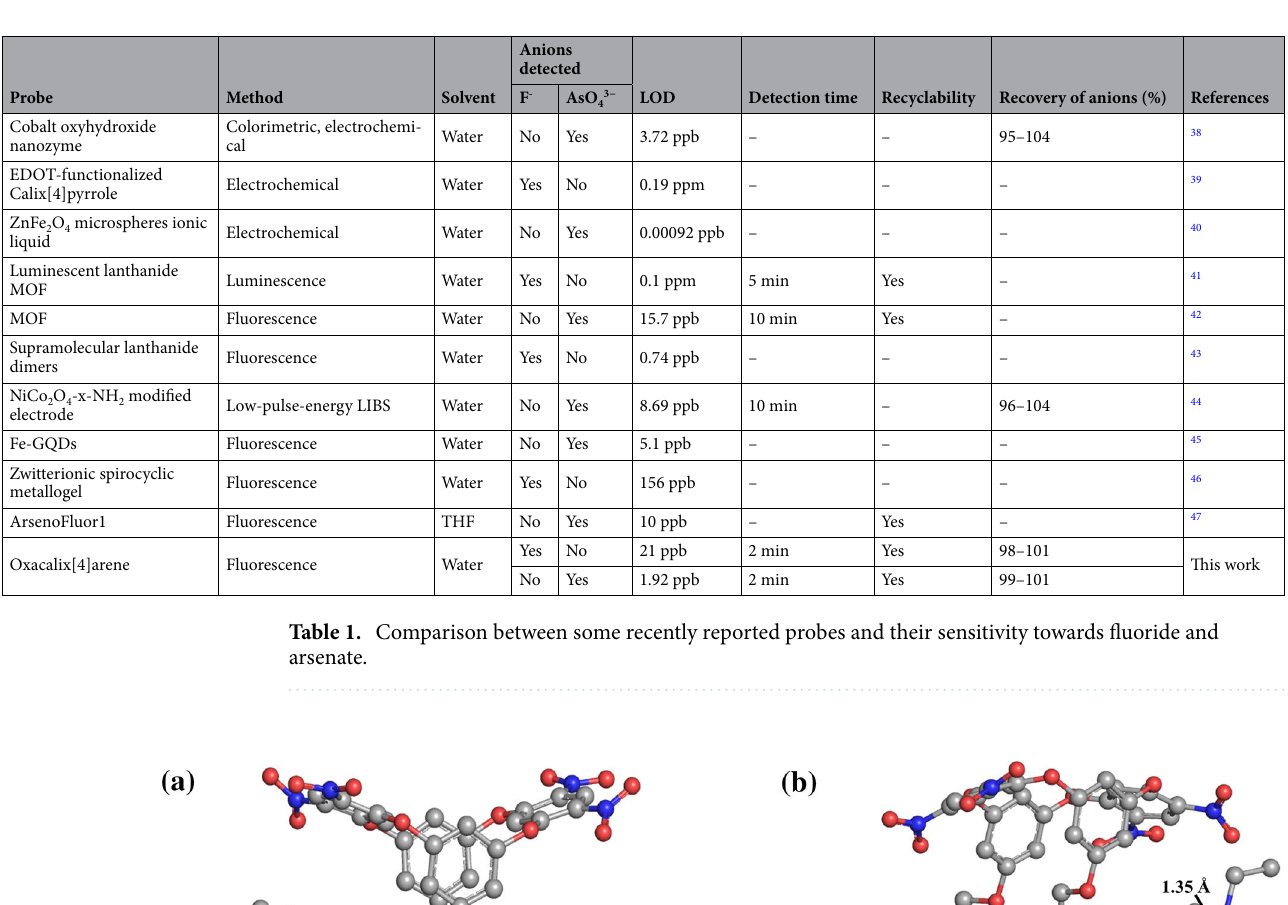
Fig. S34. There are two main lower potential regions, one is around nitro groups on the calix ring and another is near the rhodamine B part. All nitro groups are involved in resonance with calix moiety, the only possible region where the metal can bind has shown with the red region near to rhodamine B part. This surface potential mapping gave us the idea of a plausible metal ion binding site. Fluorescent lifetime decay.